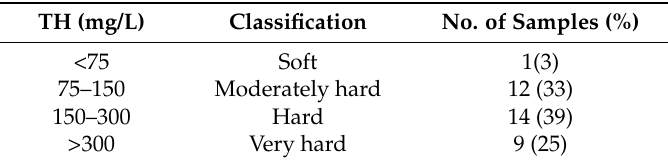
Table 7. Water classification based on TH